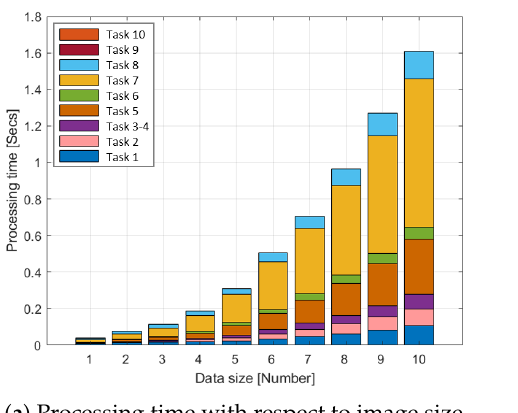
Figure 5. Data amounts along the system during the processing chain.